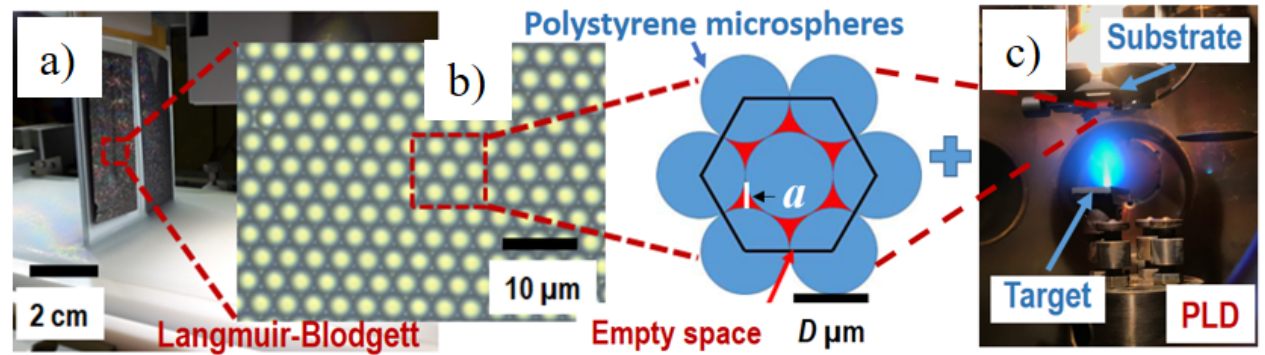
Figure 1. VO 2 –Ir microtriangles composites’ manufacturing pathway. ( a ) Photography of a perpendicular substrate covering by polystyrene spheres (P-spheres). ( b ) Schematic of spheres (P-spheres) compact arrangement. ( c ) Photography of a pulsed laser deposition process.